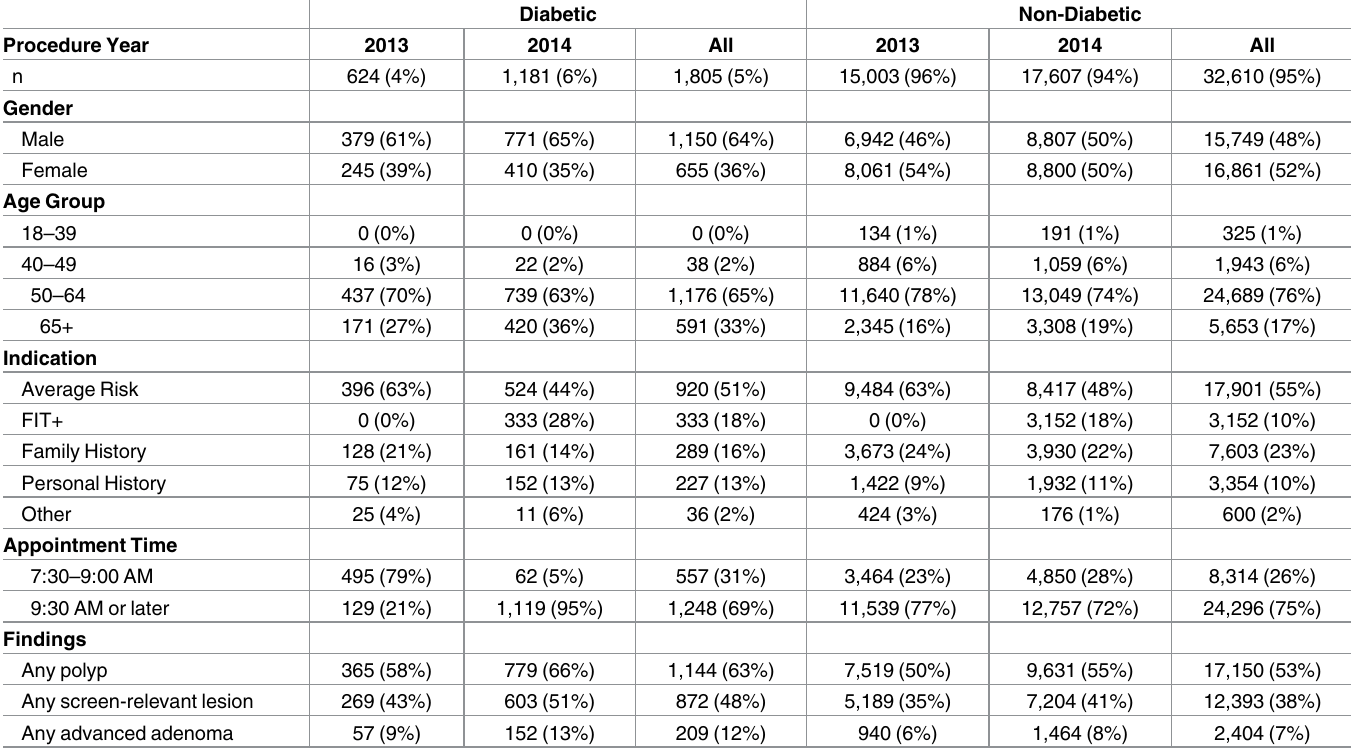
Table 1. Study population characteristics.